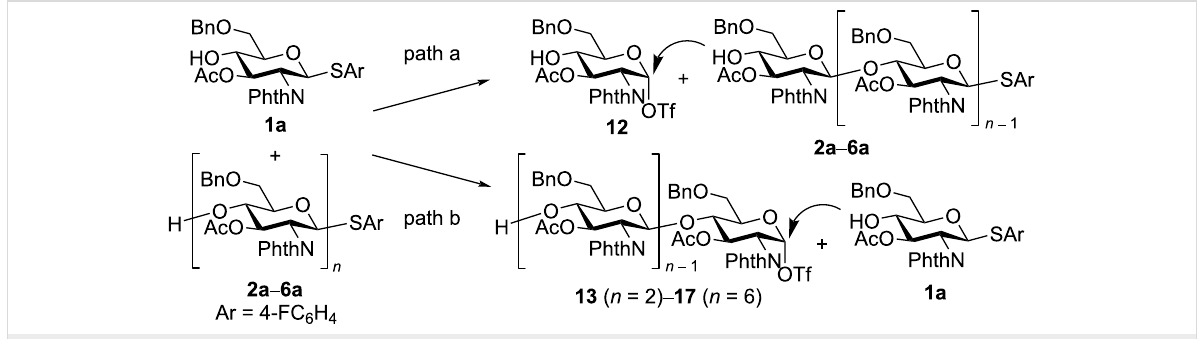
Figure 7: Proposed mechanisms of electrochemical polyglycosylation.